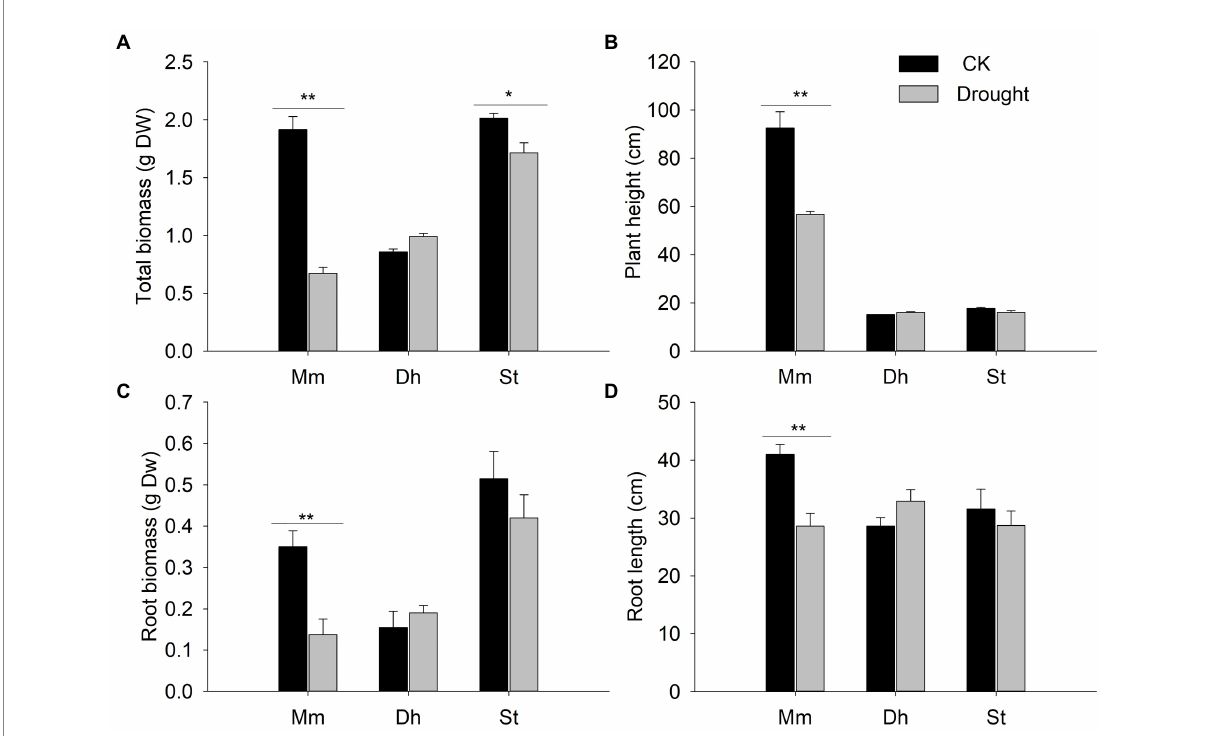
FIGURE 6 Changes of (A) total biomass, (B) plant height, (C) root biomass, and (D) root length of two replacement forage legumes and M. micrantha under drought stress (average ± SE, n = 4). Different letters above bar plots indicate significant differences analyzed using ANOVA followed by Dunnett’s test. Significance levels: ** p < 0.01; * p <